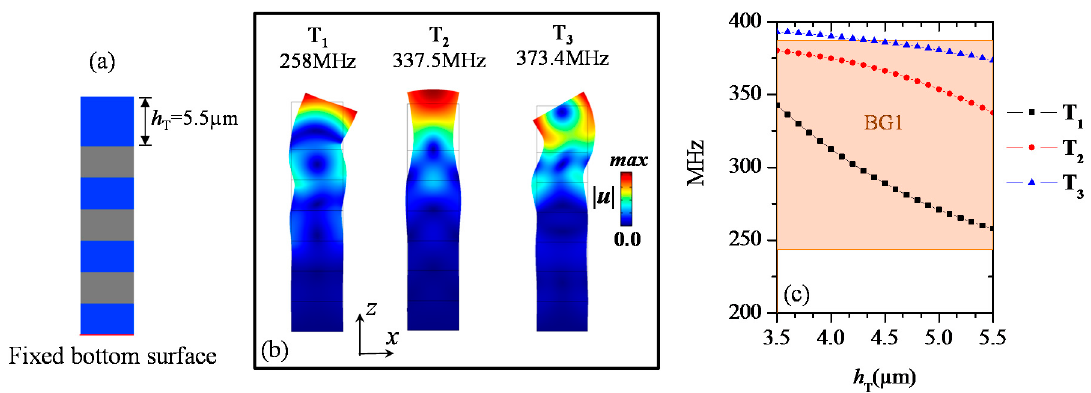
Figure 3. ( a ) Finite phononic ridge where the structural defect is constructed by changing the thickness h T of the top Si layer. The bottom surface of the ridge is fixed. ( b ) Total displacement field amplitude for the resonance modes in the phononic ridge for h T = 5.5 µm. ( c ) The resonance modes frequency shift as function of h T .